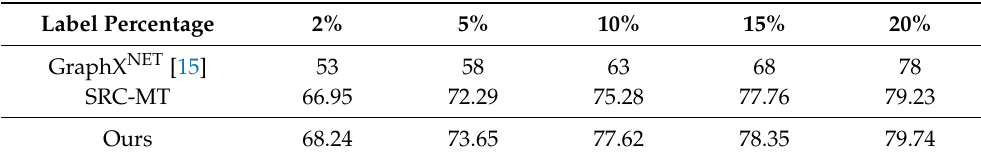
Table 3. AUC performance comparison of semi-supervised models with different markers on the ChestX-ray14 dataset.